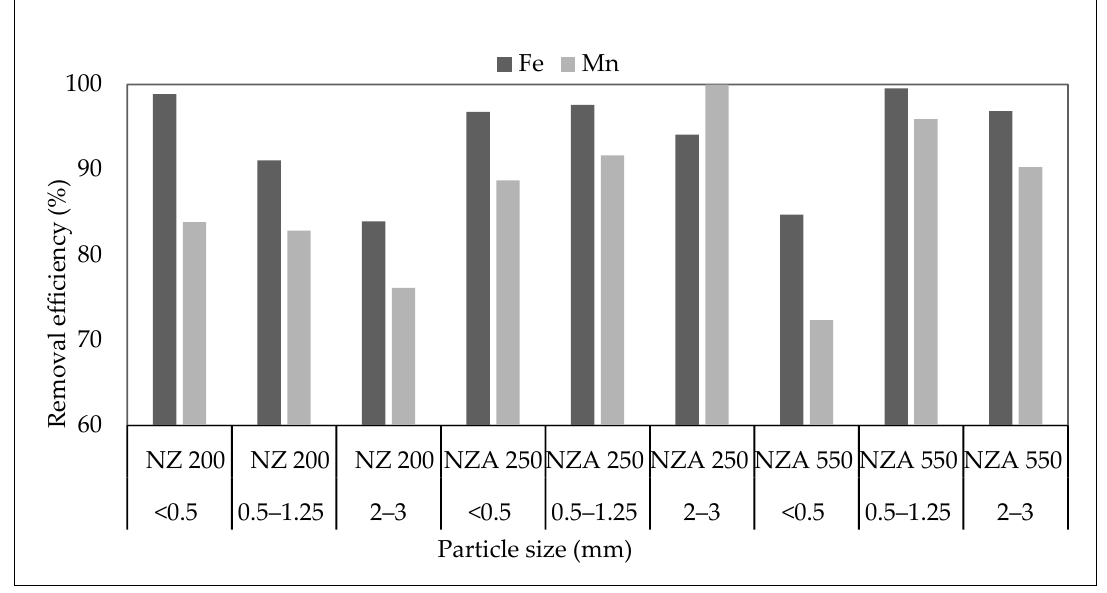
Figure 3. Simultaneous removal of Fe and Mn by NZ 200, NZA 250, and NZA 550 with different particle sizes and activation temperatures; C o = 15/5 mg/L Fe/Mn; V = 100 mL; 2 g of zeolite; 100 rpm.